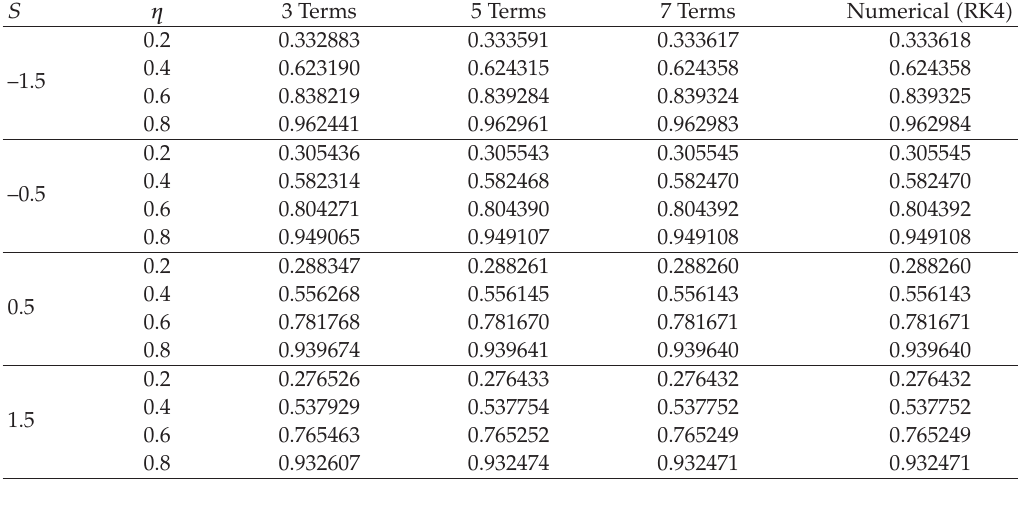
Table 2: The analytic results of f (cid:3) η (cid:4) at di ff erent terms of approximation compared with the numerical results (cid:3) RK4 (cid:4) for the two-dimensional case.